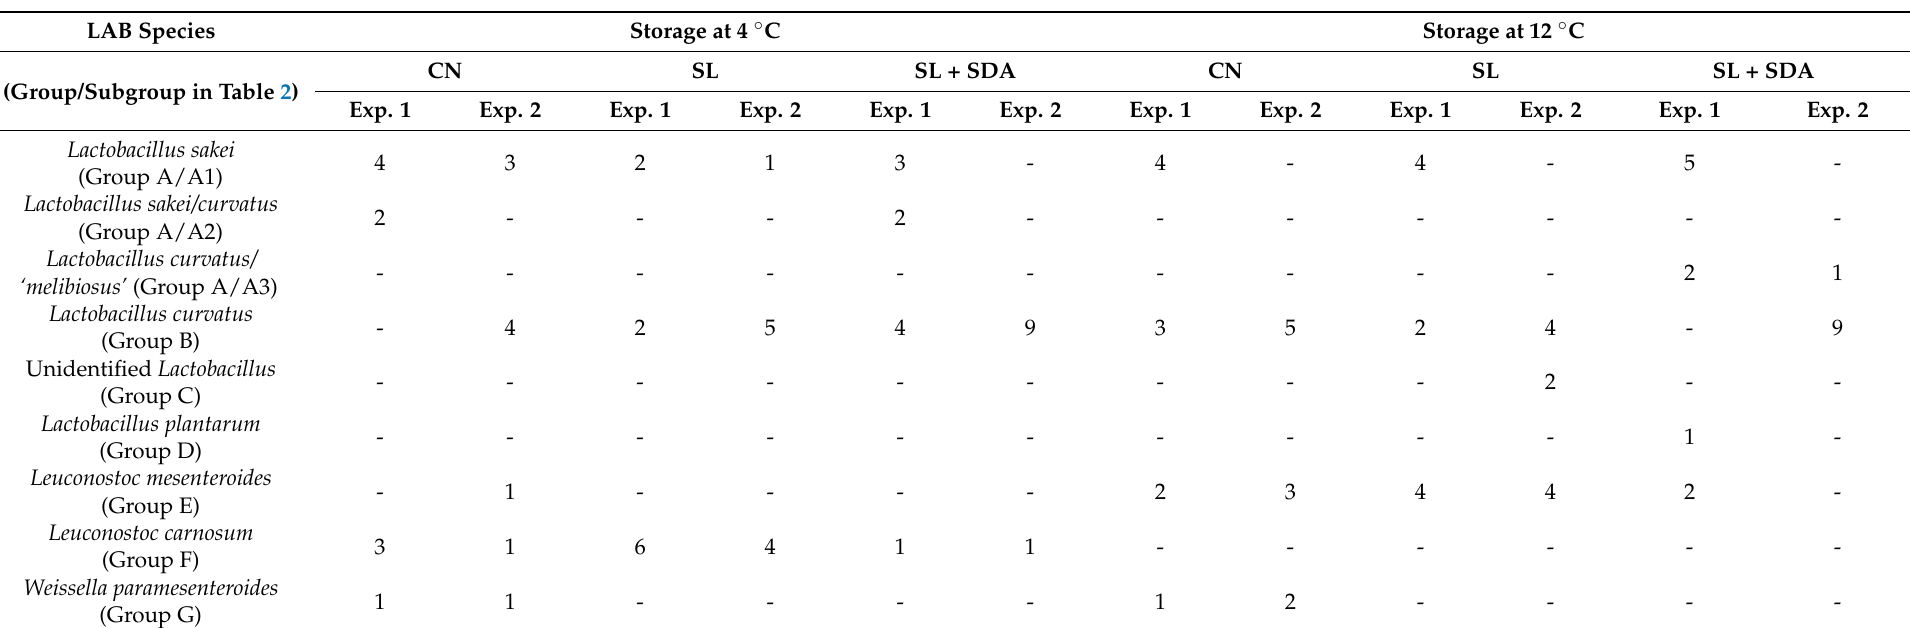
Table 5. Temperature-dependent and treatment-dependent LAB species distribution of 120 spoilage MRS isolates from two experimental trials of frankfurters manufactured with or without organic acid salts and stored at 4 ◦ C and 12 ◦ C in vacuum packages for 90 days a